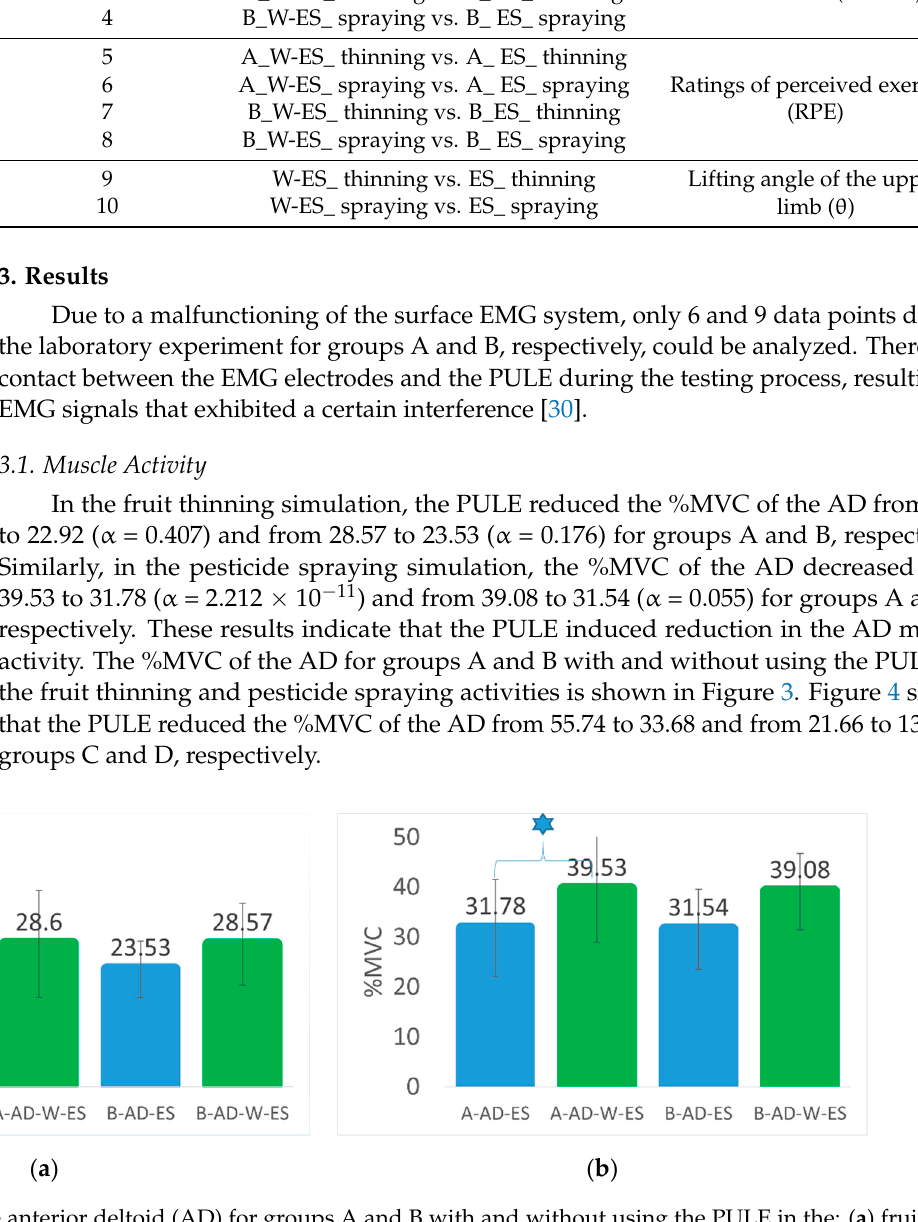
Figure 3. The %MVC of the anterior deltoid (AD) for groups A and B with and without using the PULE in the: ( a ) fruit thinning simulation; ( b ) pesticide spraying simulation. The star symbol indicates statistical significance ( α < 0.05).